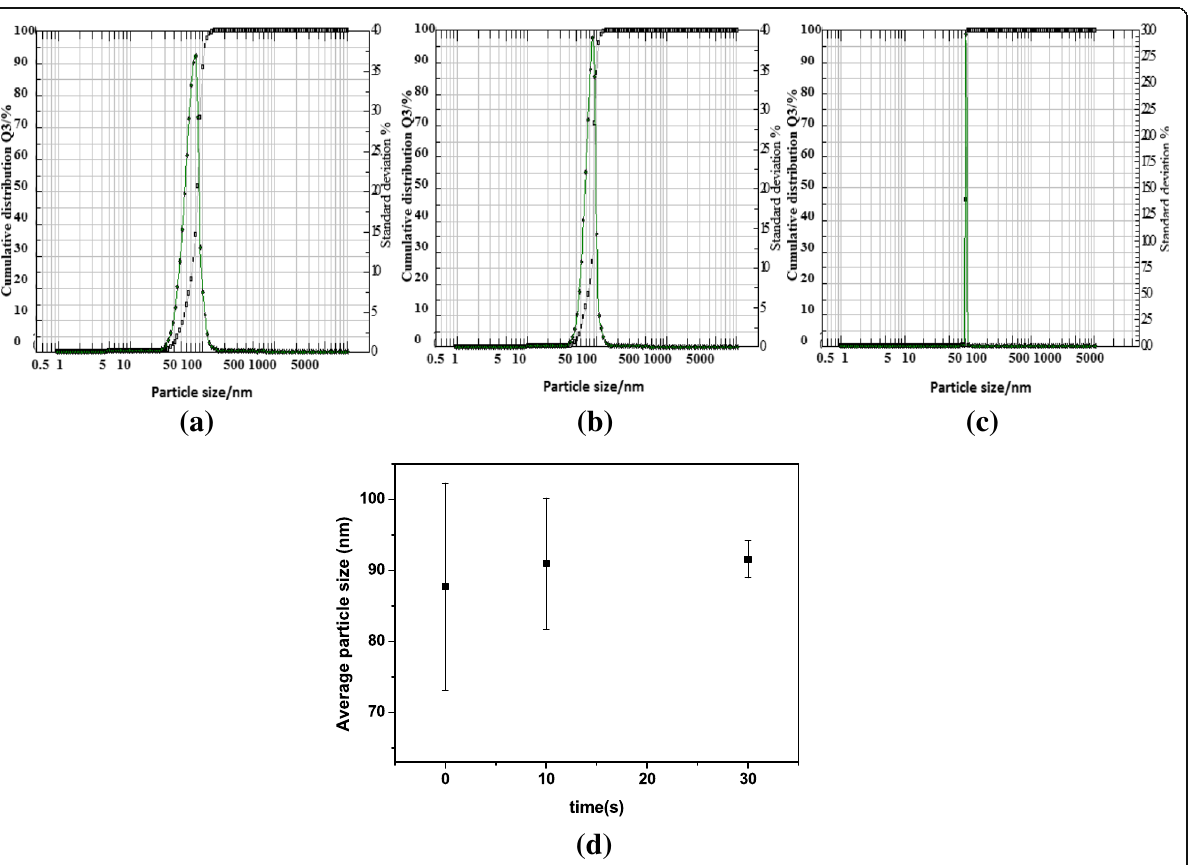
Fig. 6 The distribution density determined using the Nanophox analyzer of Al 2 O 3 particles in the suspensions a without, with irradiation after b 10 min and c 30 min, and d hydrodynamic diameter distribution of NPs in nanofluids as a function of irradiation times